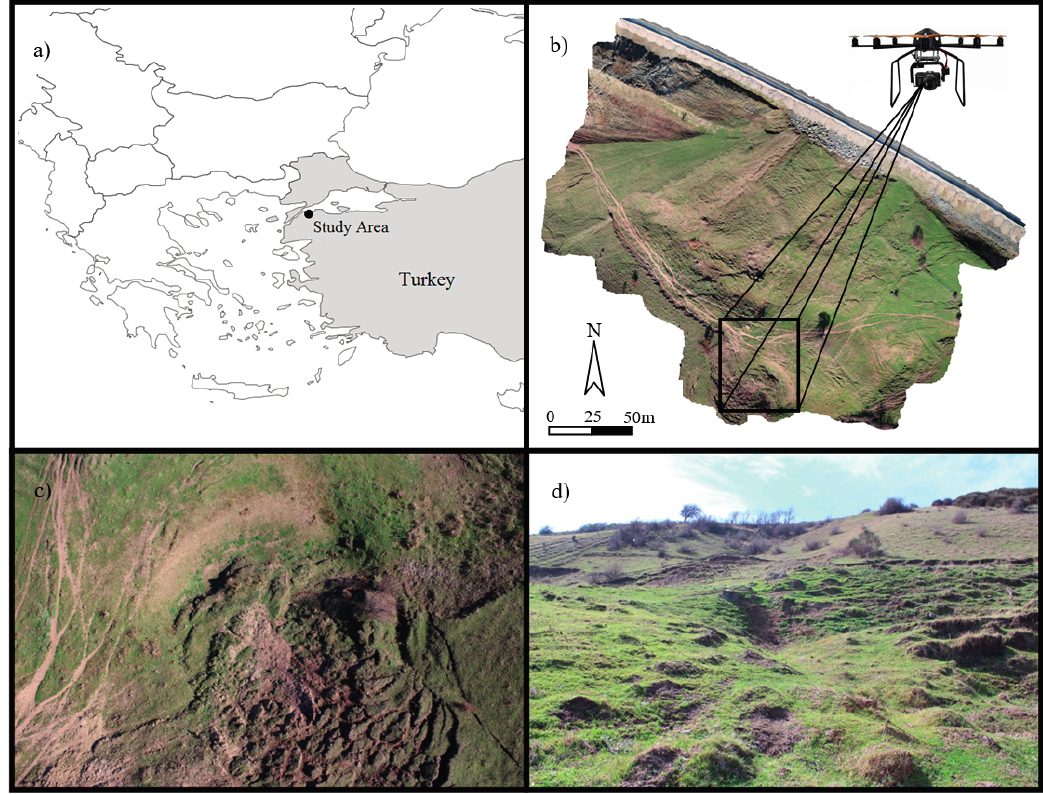
Figure 1. ( a ) Location of the study site; ( b ) the orthophoto of the landslide area and UAS with EOS M camera; ( c ) an aerial image of the landslide surface from the UAS; and ( d ) a terrestrial image of the landslide